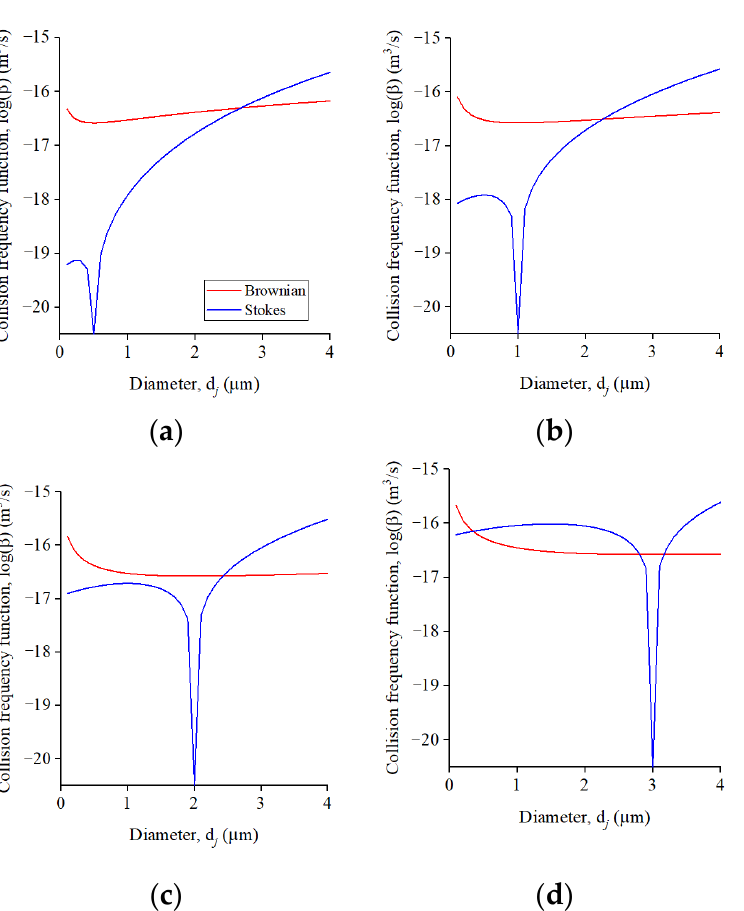
Figure 13. Comparison of collision frequency function of Brownian motion and Stokes motion for an inclusion of diameter d i ( a ) 0.5 µ m, ( b ) 1 µ m, ( c ) 2 µ m, ( d ) 3 µ m and varied d j